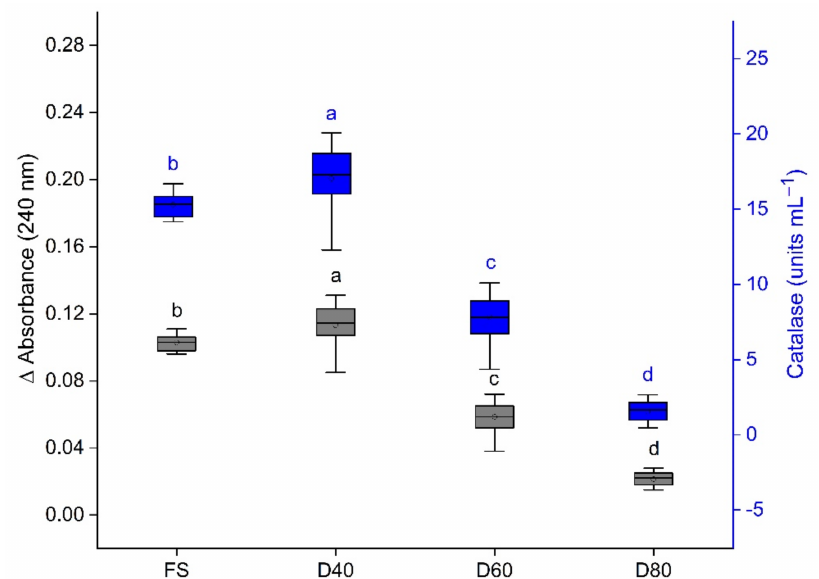
Figure 7. Absorbance and catalase activity (units mL − 1 ) of fresh mango and mango dried at 40 ◦ C, 60 ◦ C and 80 ◦ C against the fixed concentration of 0.036% H 2 O 2 substrate (initial absorbance 0.54–0.58 a.u.) for 10 min at 25 ◦ C. Different letters indicate significant differences for absorbance values and catalase activity separately at p < 0.05, ( n = 6 ×